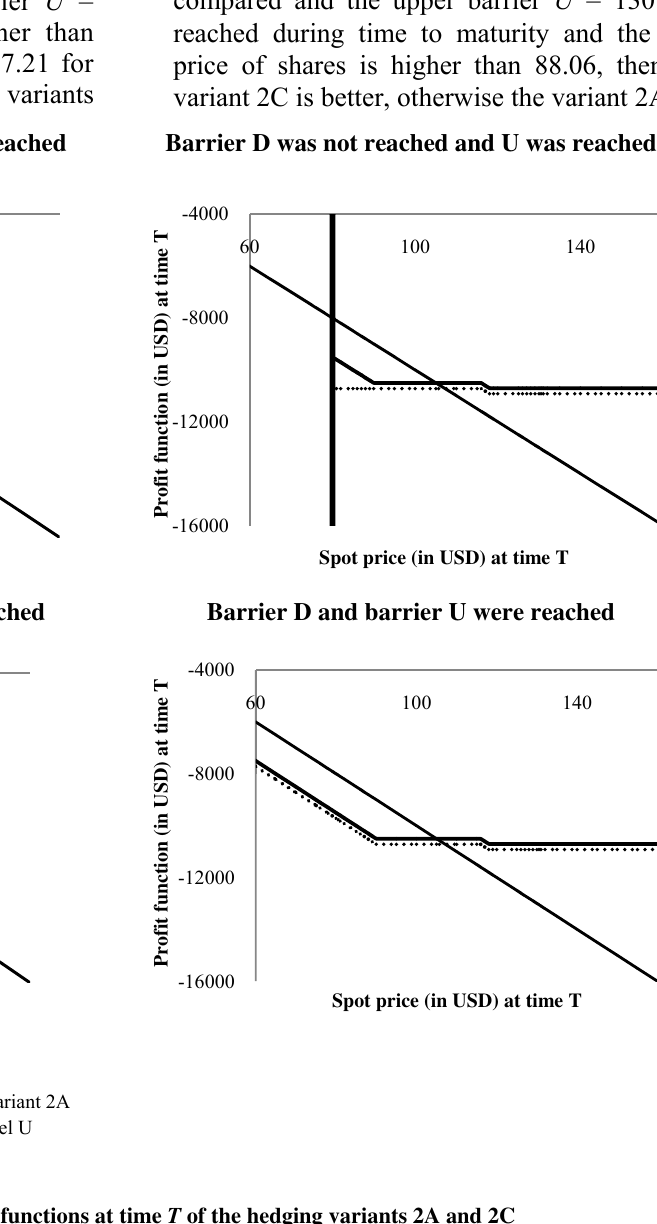
Fig. 1. Comparison of the cost functions at time T of the hedging variants 2A and